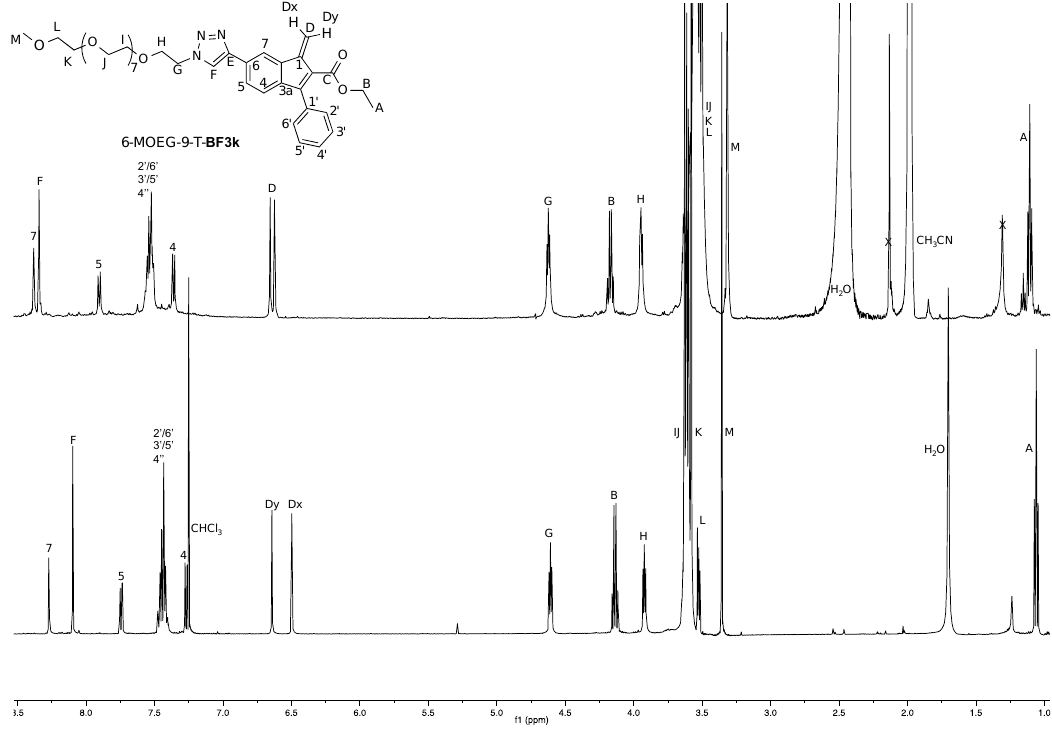
Figure 4. Comparison of the 1 H NMR spectra (500 MHz) of monomer 6-MOEG-9-T- BF3k acquired respectively in CDCl 3 (bottom trace) and in CD 3 CN (top trace).